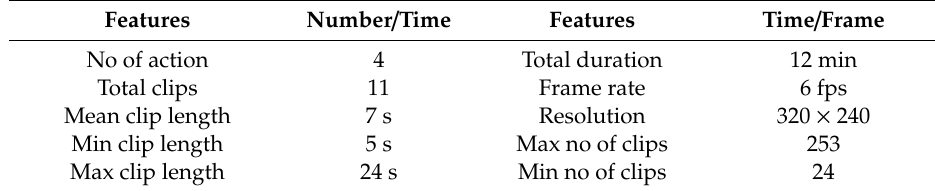
Table 1. Information about the collected lab action data